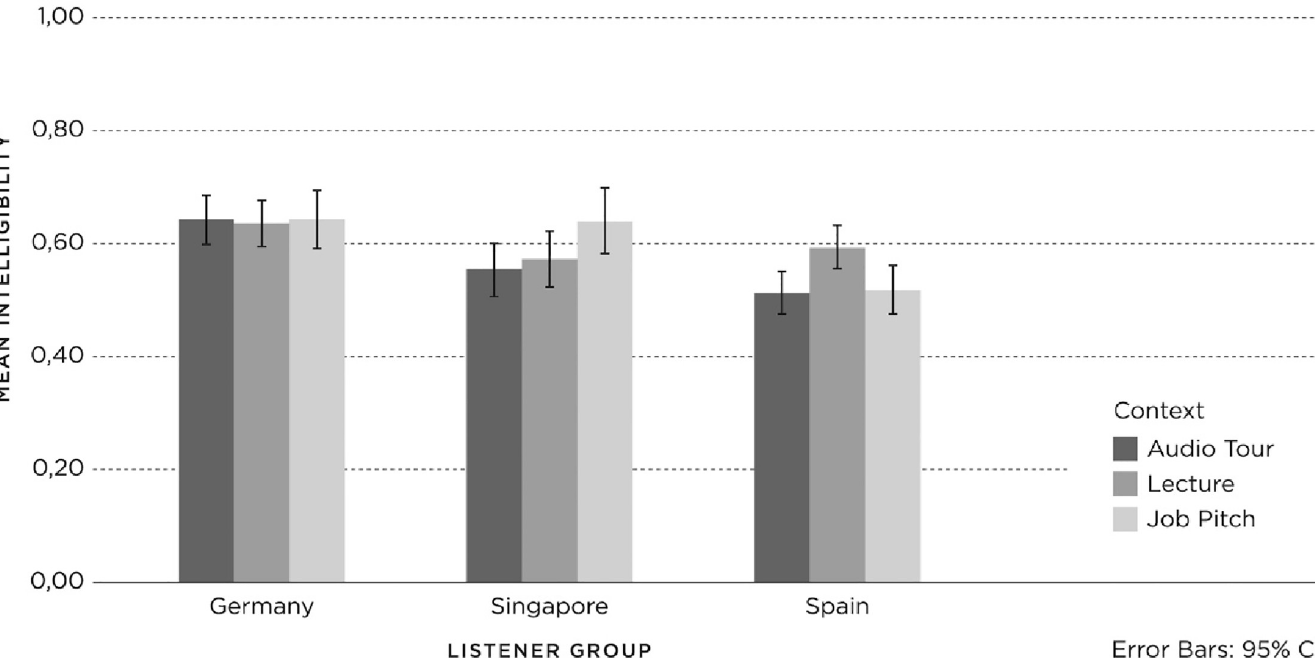
Fig 2. Mean proportions intelligibility for context (Audio Tour, Lecture, Job Pitch) and listener group (Germany, Singapore,